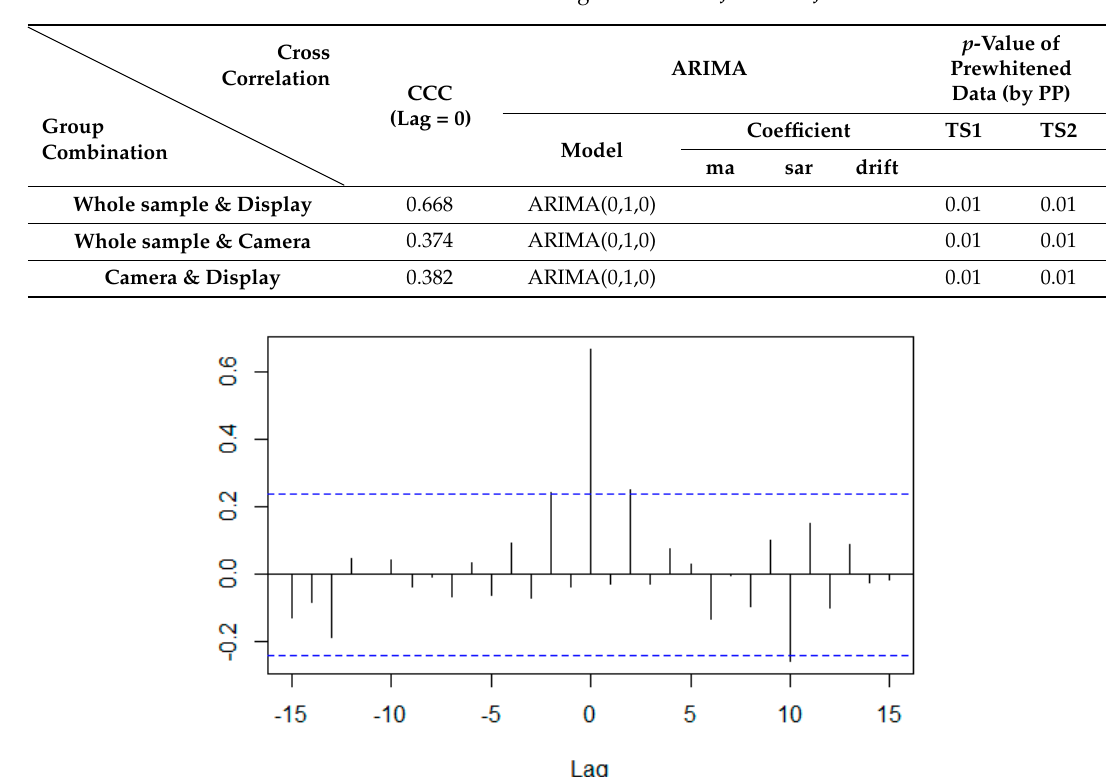
Figure 18. Cross-correlation coefficient between the average BHAR of the whole sample group and the average BHAR of the display group for Jan 2013–Jul 2018.